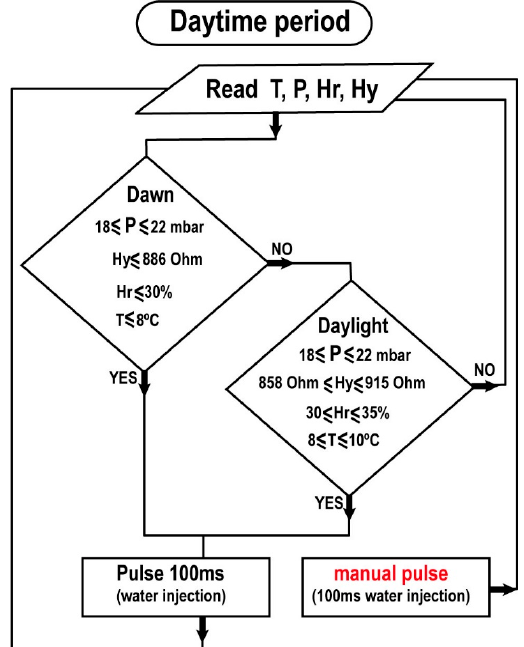
Figure 10. Injection algorithm during the daytime period. The variables are pressure P, sample temperature T, relative humidity Hr, and hydration Hy. temperature T, relative humidity Hr, and hydration